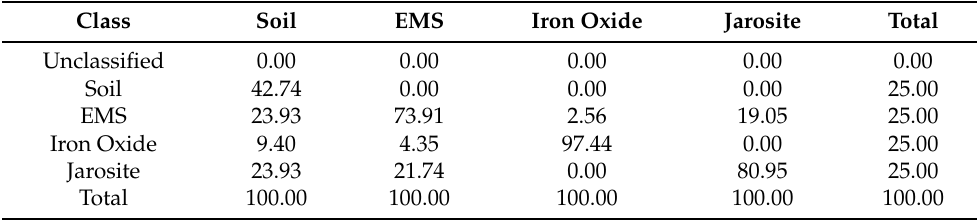
Table A8. October 2020 maximum likelihood. Overall accuracy points: 122/200, overall accuracy: 61%, kappa coefficient: 0.48.